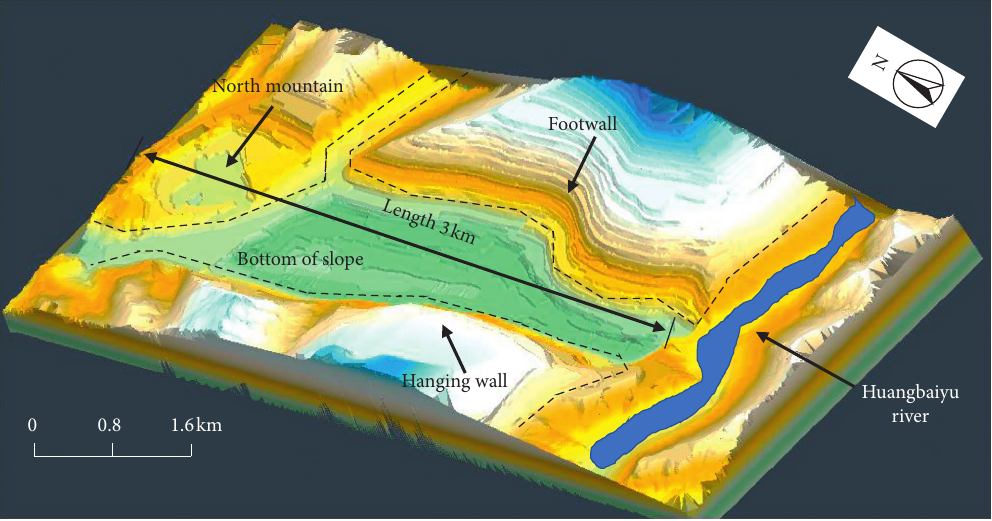
Figure 2: Mine mining site shape and landform. Table 1: Characteristics of typical rock sections of the Dagugou